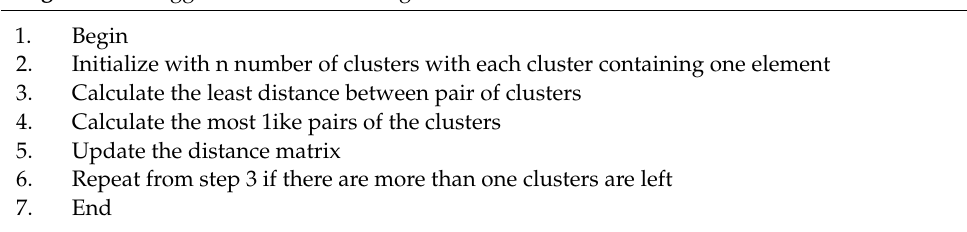
Algorithm 1: Agglomerative